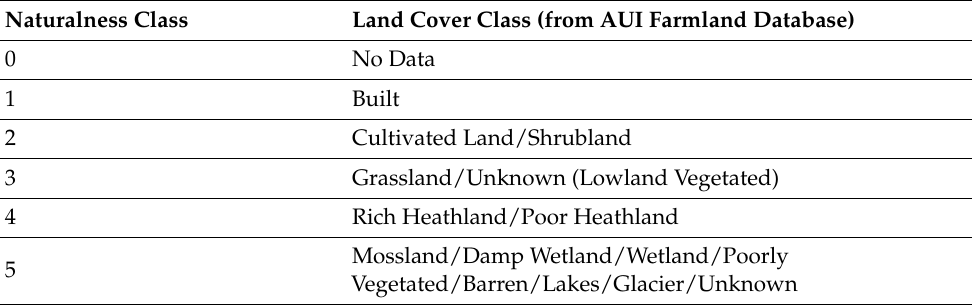
Table 2. Naturalness classifications applied to AUI Farmland Data. Naturalness Class Land Cover Class (from AUI Farmland